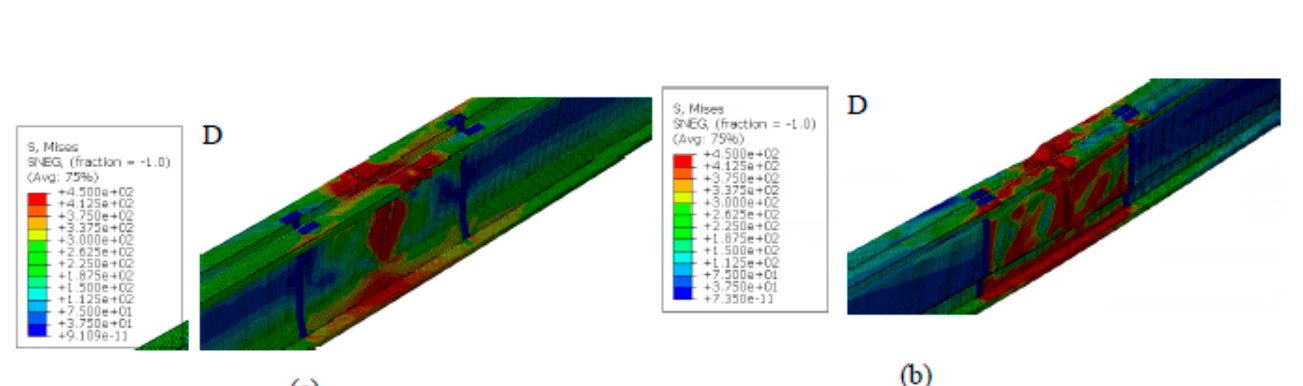
Figure 13. Failure patterns of built-up sections: ( a ) Folded-Flange; ( b ) Super-Sigma. With regards to the built-up sections, maximum bending capacity enhancement was obtained for folded-flange built-up sections compared to their single sections for all three materials except CFS with grade of 220 MPa and CFS stainless steel with 1.4307, where the benchmark section showcased a higher increment. Increment in the flexural strength of studied built-up section for CFS grade of 220 MPa varies from 114% (super-sigma) to 197% (benchmark), whilst variation lies between 119% (optimised-LCB) and 137% (folded- flange) for CFS with 450 MPa. For aluminium, the increment pattern was similar and variation in the amount of increment for H14 and H48 was 160% to 230% and 137% to 238%, respectively, and the minimum increment was in optimised-LCB, while